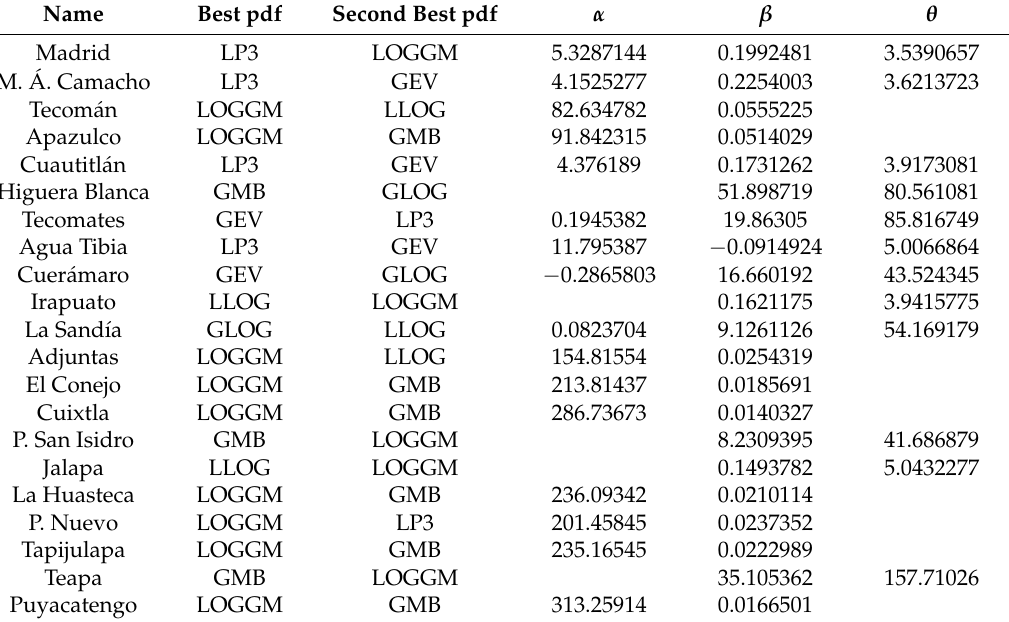
Table 2. Parameters of the best fitting probability distribution